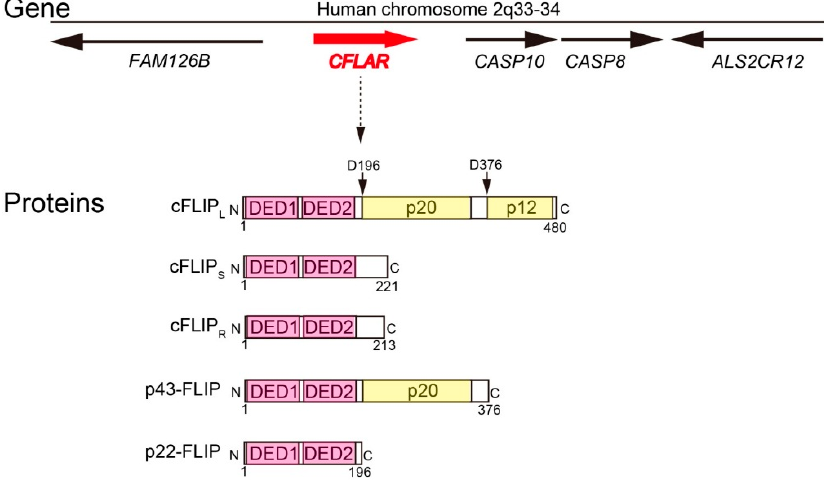
Figure 1. The structures of gene and proteins for human cFLIP. For gene structure, the red arrow ( CFLAR gene) and black arrows (the nearby genes) indicate the positions and directions of genes present on human chromosome 2q33-34. For protein structures, light magenta and light yellow boxes indicate DEDs and caspase-8-like domains, respectively. The numbers below the boxes indicate amino acid residues, and arrows above the boxes indicate the caspase-8-mediated cleavage sites.